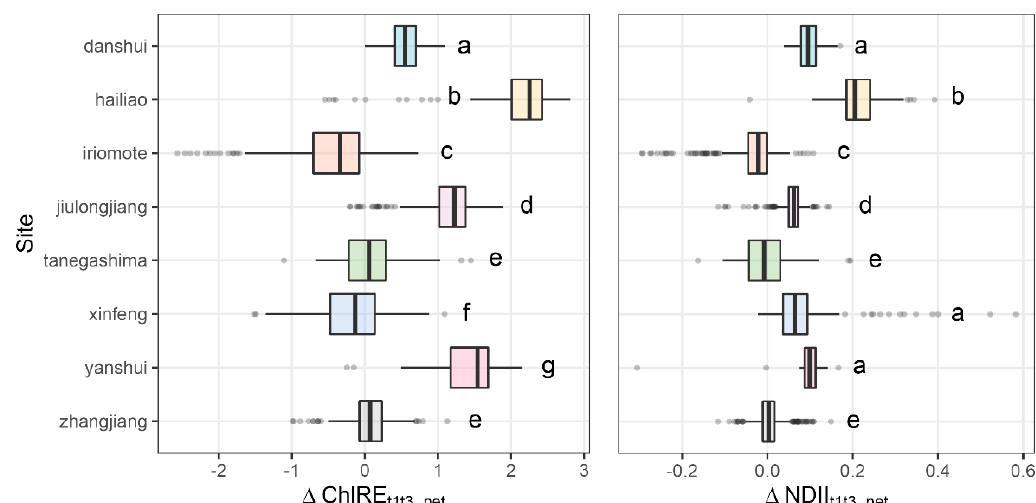
Figure 3. Net change of the chlorophyll red-edge index (ChlRE) and normalized difference infrared index (NDII) between t1 (pre-cold wave) and t3 (one month after cold wave) in eight mangrove sites in East Asia. Letters denote statistical grouping (i.e., for each index different groups are significantly different) based on the procedure of Herberich et al. [73] that compares means of groups of unequal sizes and in absence of normal distribution (95% confidence intervals in Table S4).